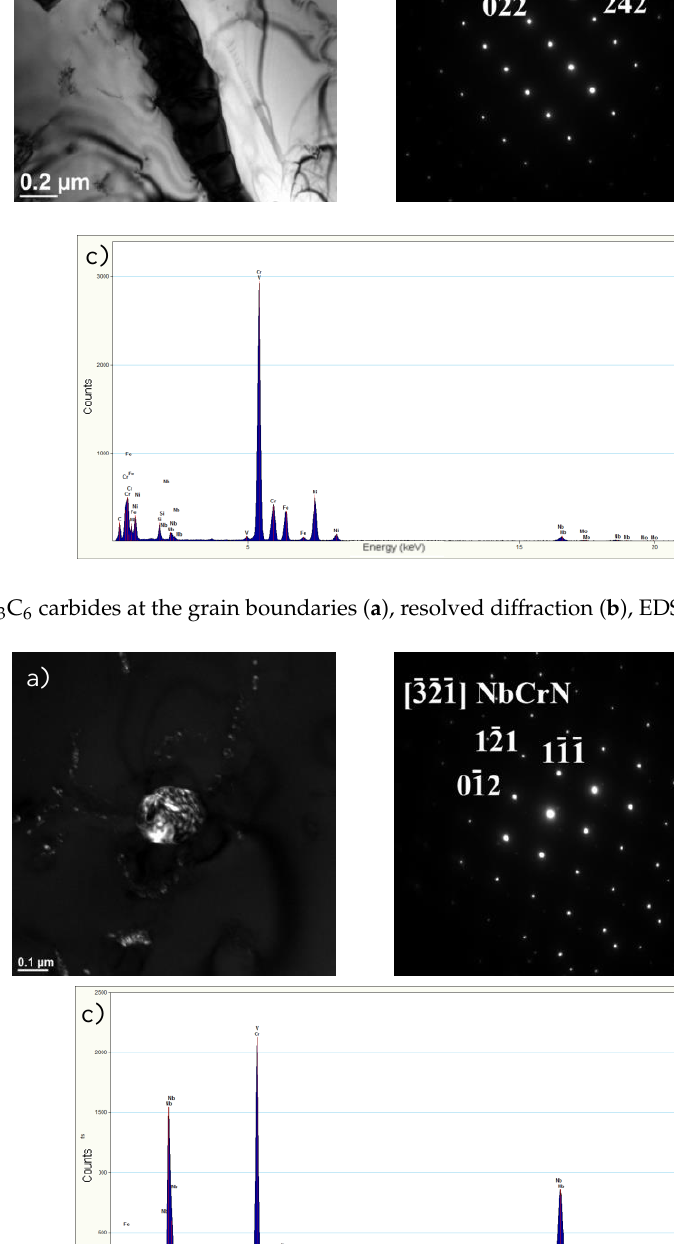
Figure 6. Secondary Z-phase ( a ), resolved diffraction ( b ), EDS analysis ( c ); TEM.